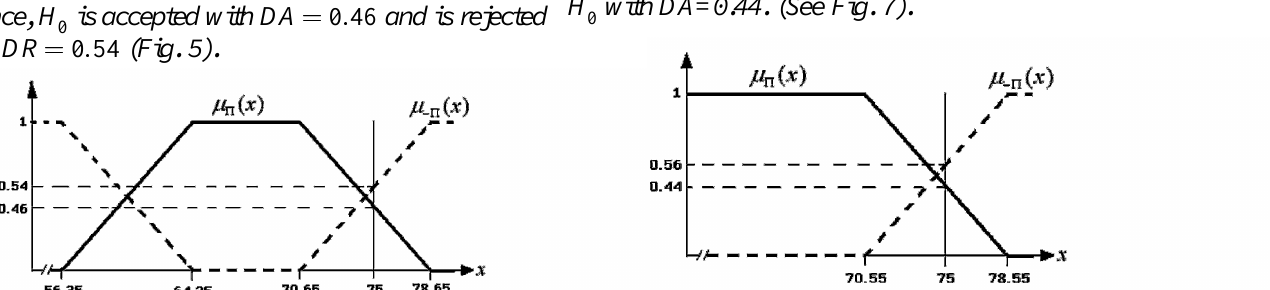
Fig. 5. H is rejected (accepted) with DR=0.54 (DA=0.46). 0